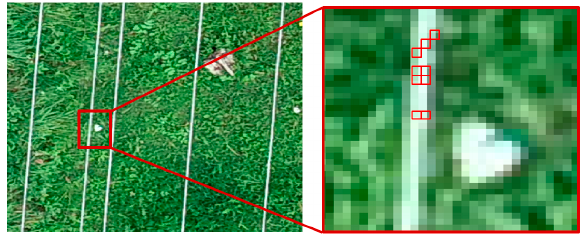
Figure 4. Fragment of the lines and background image for dataset II—GSD 3 mm.